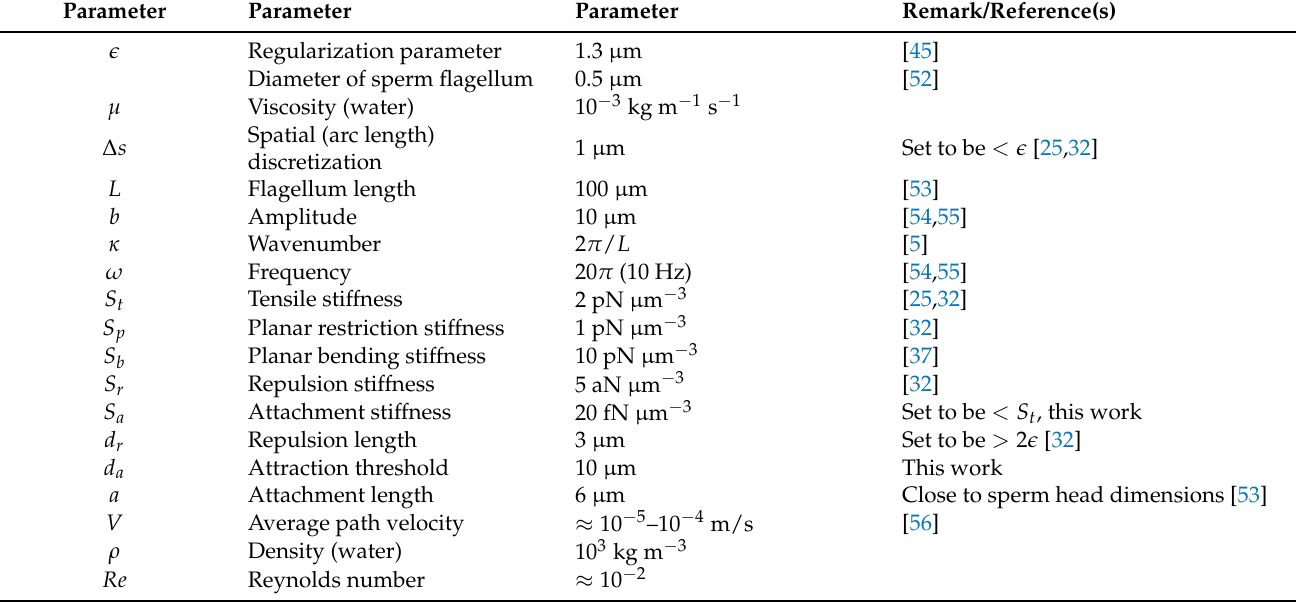
( d ) Parallel grid, closest ( e ) Perpendicular grid, ( f ) Cylindrical. flagella are 1 µ m from wall. heads are 1 µ m from wall. Figure 6. Other initial configurations used. Panels ( a – c ) shows phase differences between nearest neighbors. Panels ( d – f ) show configurations with a planar surface (wall) at x = 0. All panels have 9 flagella, with the exception of ( a ), in which 8 flagella are used to maintain the out of phase pattern amongst nearest neighbors. All units are in µ m. Table 1. Parameter values. Sperm parameters were set to that of a typical mammalian sperm with active motility. Wherever possible, biologically-measured values were used. In absence of biologically-measured values, values from prior modeling work were used, if they